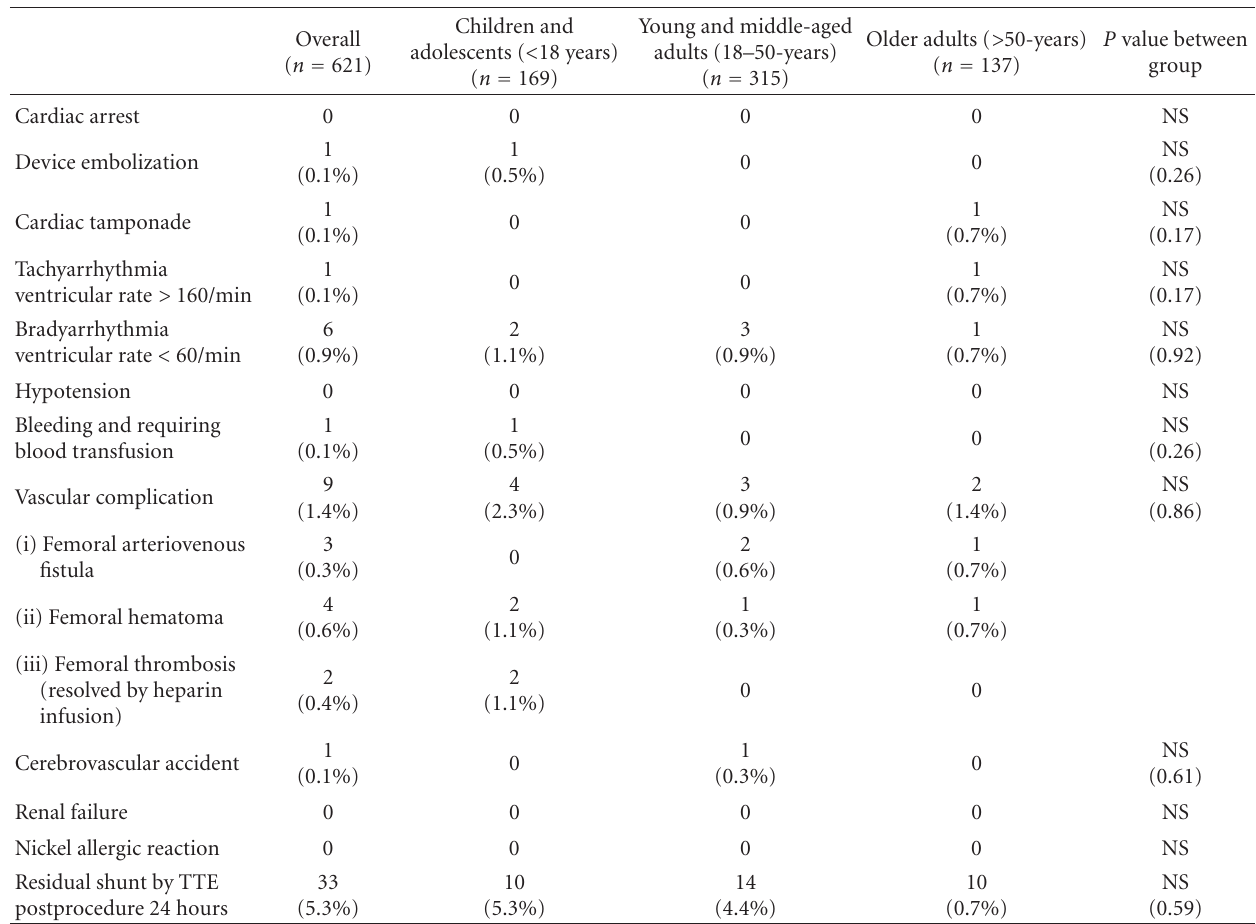
Table 6: In-hospital complications following transcatheter closure of ASD ( n =